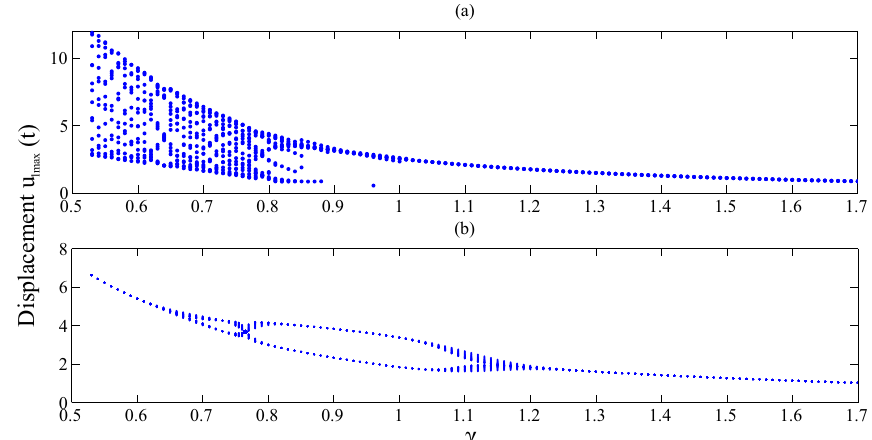
Figure 9. Bifurcation diagram γ versus local maximum from the time series u lmax (t) (cid:53) = ( 0 . 25 , 0 . 8 ,γ) , µ = 3, α = ( 1 . 6 , 0 . 2 , 0 . 1 ) , sub- damped system. In panel (a) ω = 0 . 1, and in (b) ω = 1 . 2.